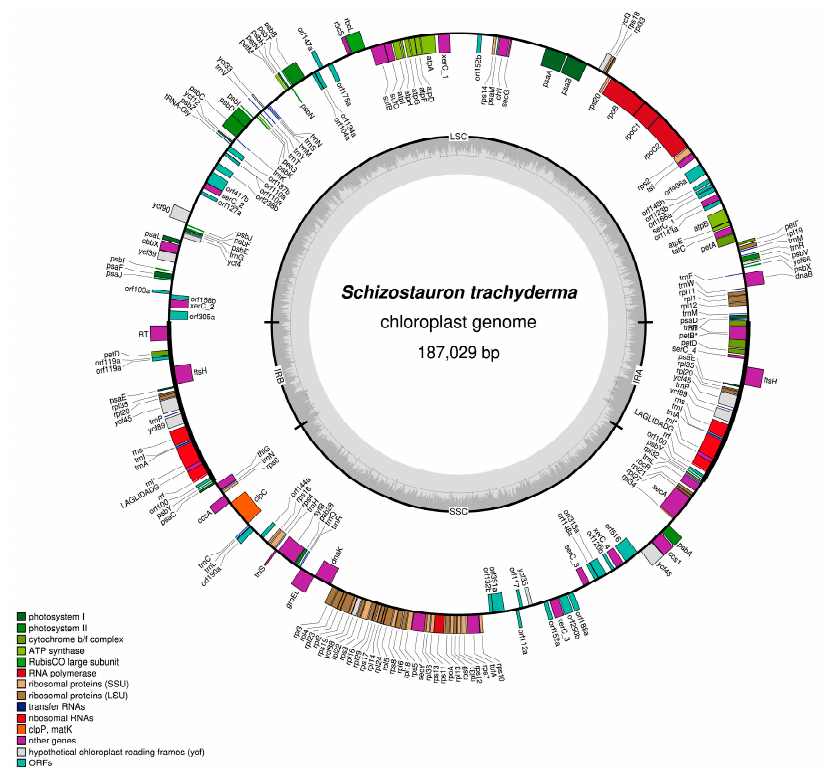
Figure 4. Map of the plastid genome of S. trachyderma . Table 1. List of the various ORF found in the mitochondrial and plastid genomes of Schizostauron trachyderma , with the name, position, putative conserved domains, and best blastp result.